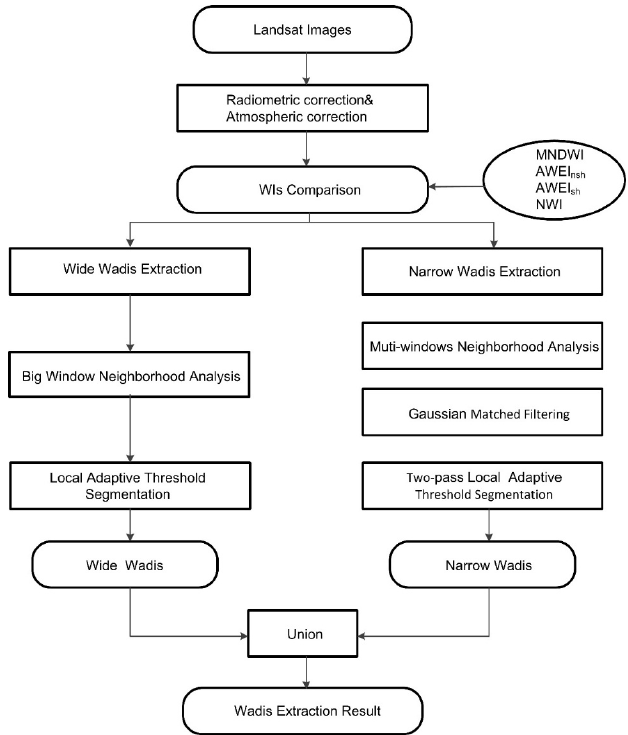
Figure 2. Procedural flow chart for wadi extraction.